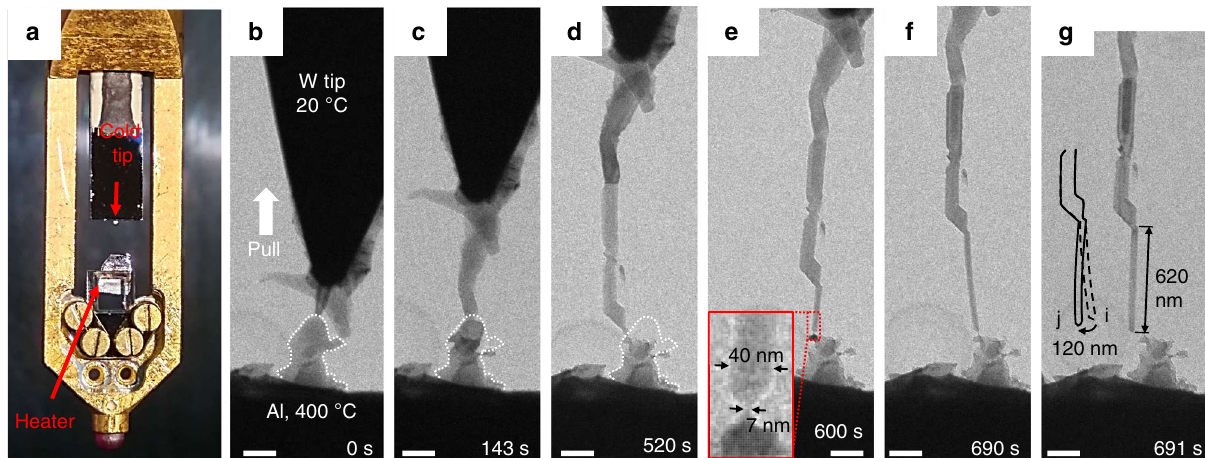
Fig. 2 The experimental setup and the process of making an aluminum nanowire by drawing from an Al hot solid substrate. a The front end of the TEM sample holder is mounted with a miniature resistive heater, opposite to which is a cold movable tip. b – d After heating the aluminum substrate to 400 °C, the cold W tip was brought to contact with the hot substrate. Upon pulling, an aluminum nanowire grows out between the tip and substrate. The pro fi le of the substrate near the contact point is depicted with the dashed white line and superimposed to ( c ) and ( d ), indicating that the mass was sucked up to build the nanowire. e When a slim neck-shaped ligament formed between the nanowire and substrate, uniform growth of the nanowire was observed to ensue. The characteristic diameter of the neck and the nanowire is measured to be 7 and 40 nm, respectively. f , g With the pulling tip ascending, the nanowire grew longer to 620 nm, until the lateral tip shift bent the nanowire to breakup. The inset sketch compares the nanowire pro fi le before and after relaxation. Scale bars in ( b – g ) represent 200 nm